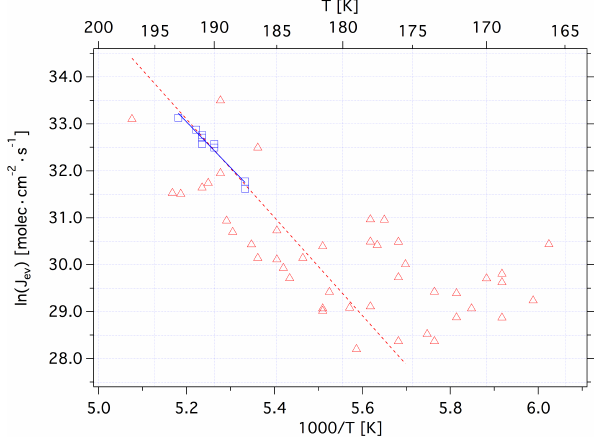
q 6H 2 O. Red trian-